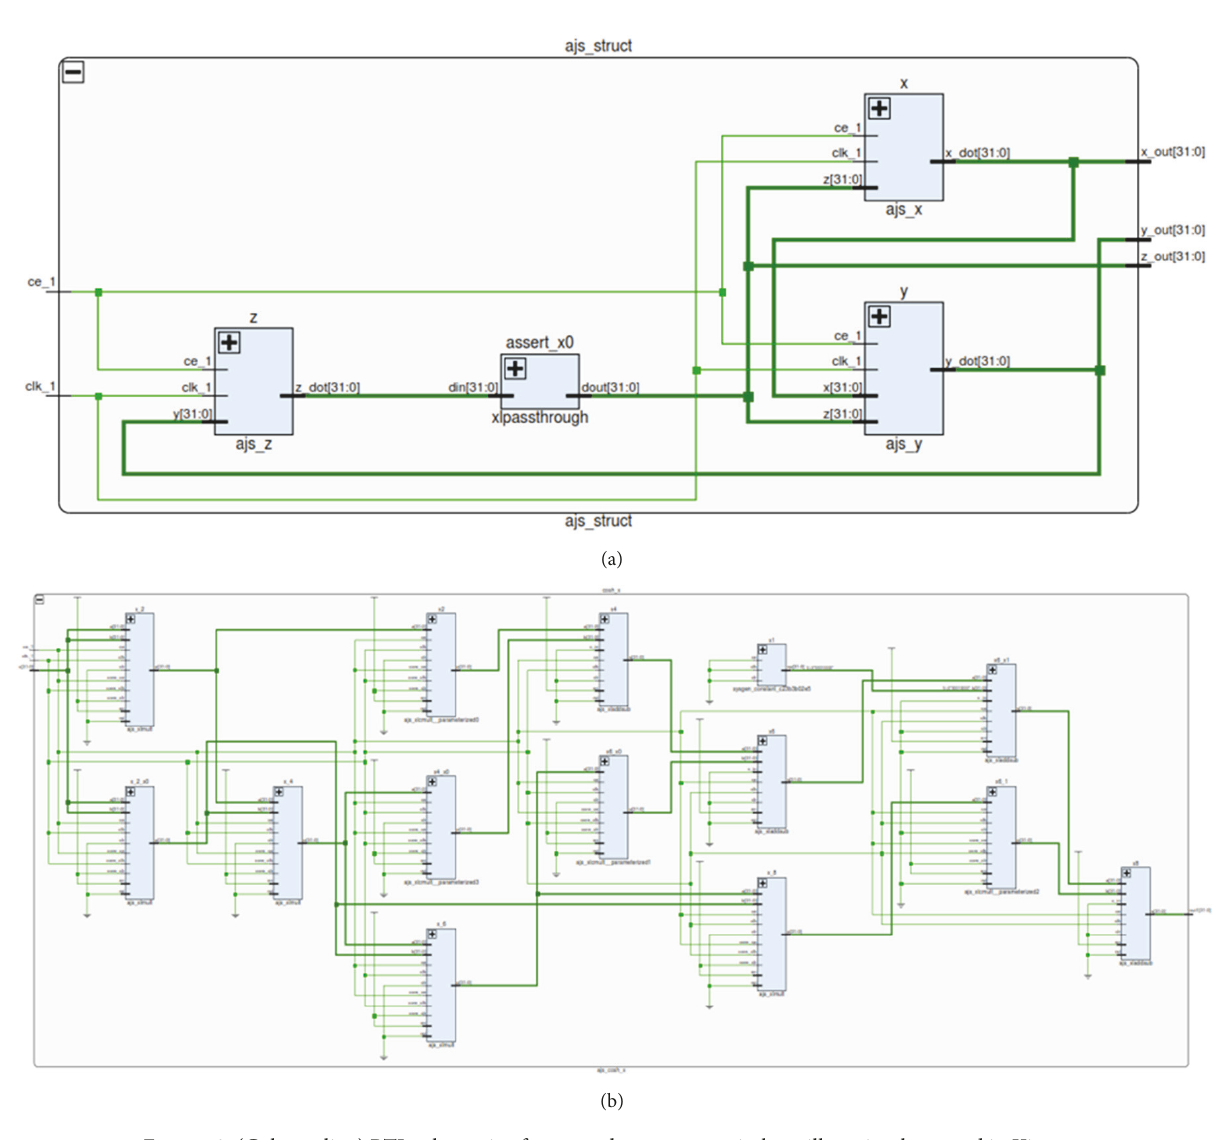
Figure 8: (Color online) RTL schematic of proposed autonomous jerk oscillator implemented in Kintex 7.